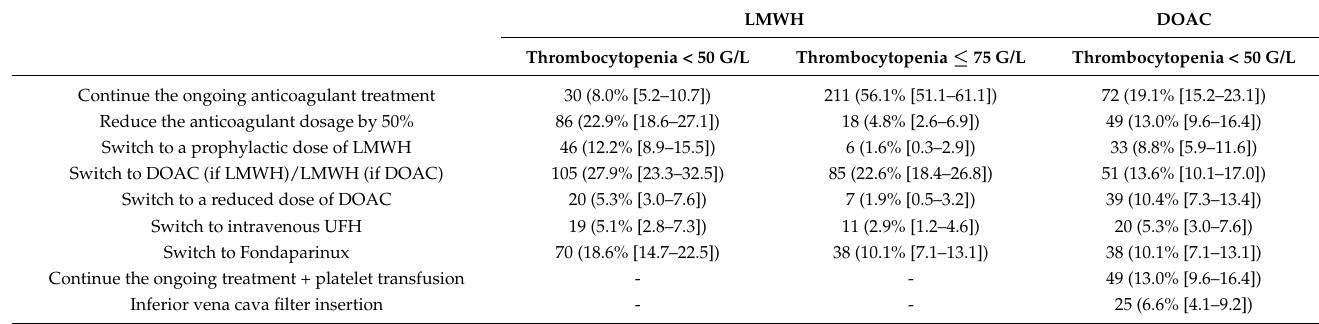
Table 3. First-line proposed management of patients with thrombocytopenia at Day 22 of anticoagu- lant